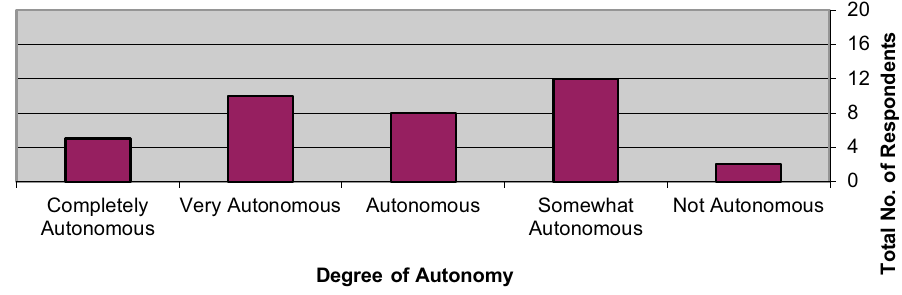
volunteers.Figure 5. Self-assessed autonomy in reintroduction